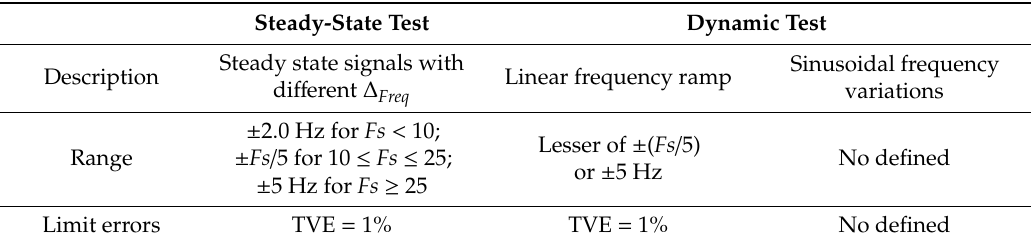
Table 1. Compliance tests for M-class